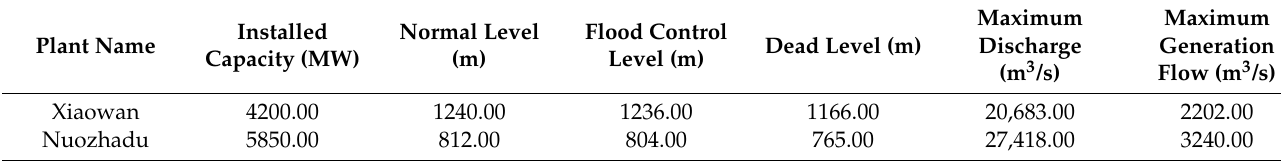
Figure 3. The distribution chart of Xiaowan and Nuozhadu. Table 1. Characteristics of hydropower plants.